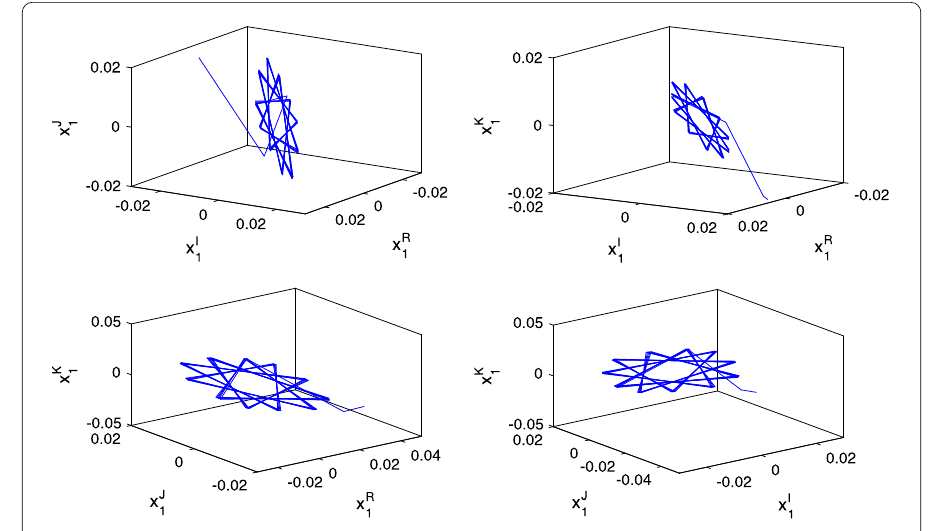
Figure 2 Curves of x 1 in a 3-dimensional space for the stable case